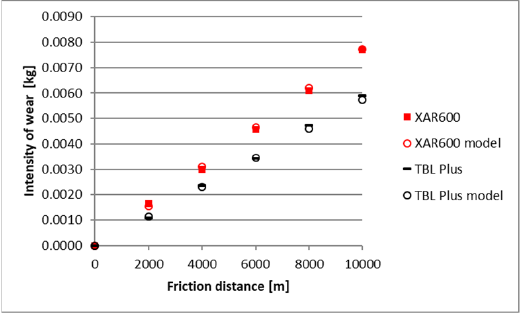
Figure 14. The course of theoretical and empirical wear of XAR 600 and TBL steels in heavy soil.